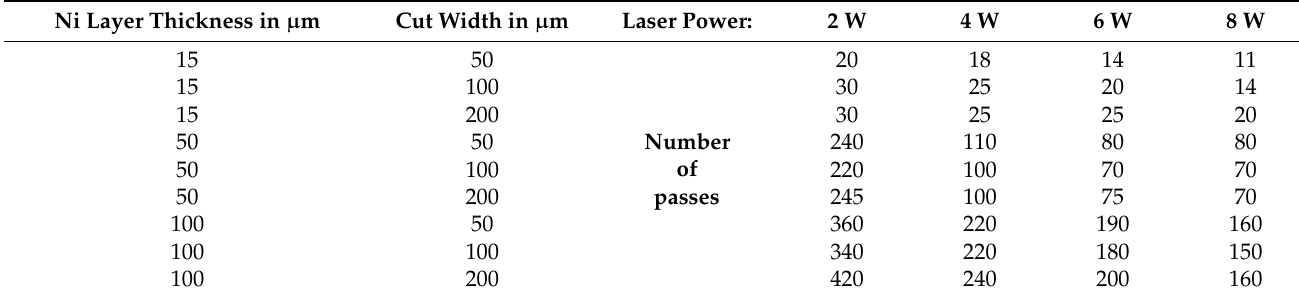
Table 2. Results of the parameter variation of the laser ablation process. The table gives an overview of the number of passes needed to fully ablate the electroplated nickel layer in the desired area depending on layer thickness, cut width and laser power.